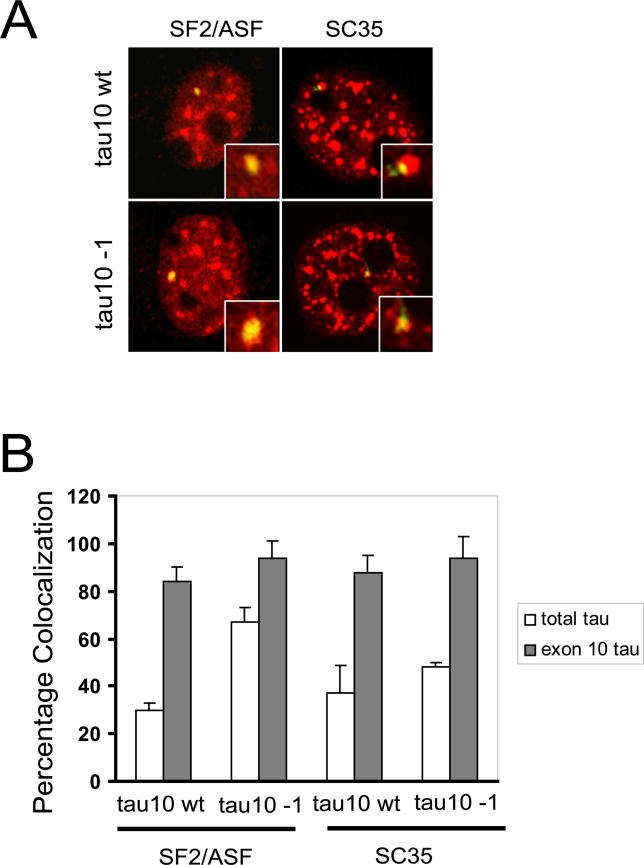
Recruitment of Endogenous Pre-RNA Splicing Factors to Transcription Sites Containing tau Exon 10 mRNA(A) Recruitment of splicing factors to tau transcription sites detected by combined RNA-FISH using a specific probe against tau exon 10 (green) and IF microscopy with specific anti-splicing factor antibodies (red). All associations were confirmed by linescan analysis. Scale bar = 2.5 μm.(B) Quantitation of percentage of cells with colocalization of tau RNA-FISH and splicing factor signals. Values represent averages from at least 100 transcription sites from at least three experiments ± SEM. Recruitment to the subpopulation of transcription sites containing predominantly tau exon10 mRNA in tau10wt cells was as efficient as recruitment in tau10−1 cells.